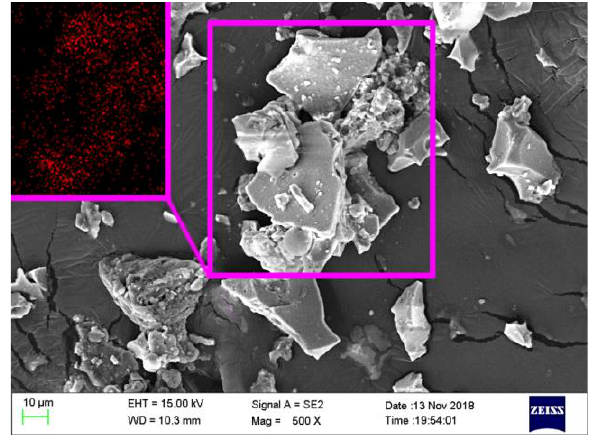
Figure 2. XPS spectra in the Fe2p region of EBFS